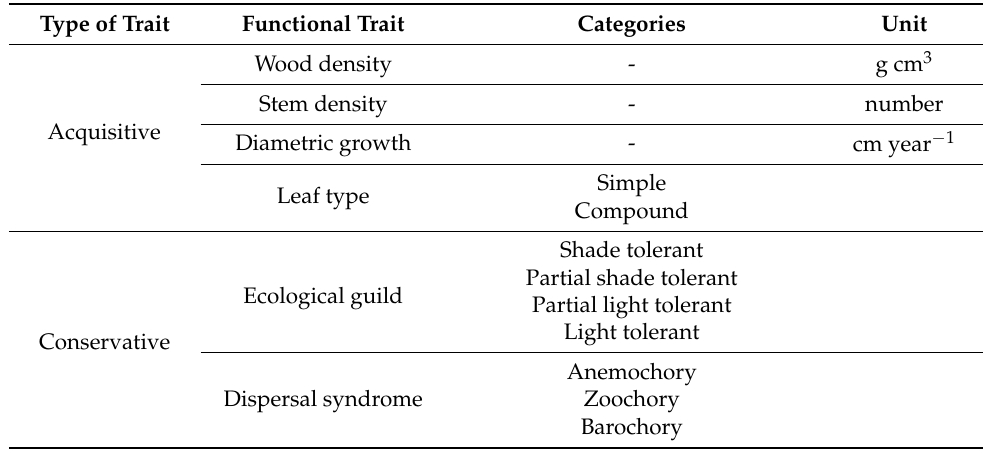
Table 1. Functional (conservative and acquisitive) traits, including categories, units and codes used to separate forest